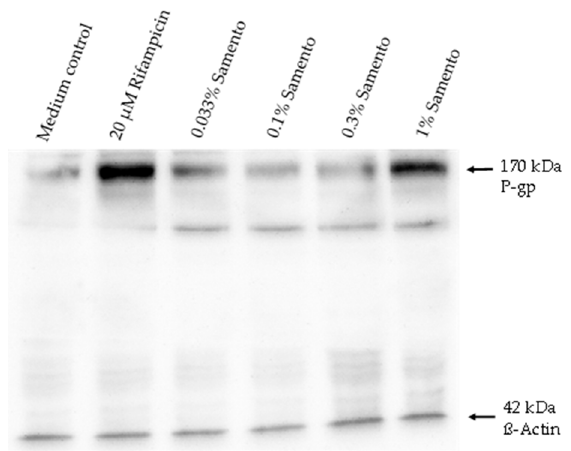
Figure 5. Effects of Samento (0.033–1%) and the positive control rifampicin (20 µM) on the protein expression of P-glycoprotein (P-gp) after four days of exposure. β -actin was used as a loading control. Exemplarily, 1 blot of a series of 5 is depicted.